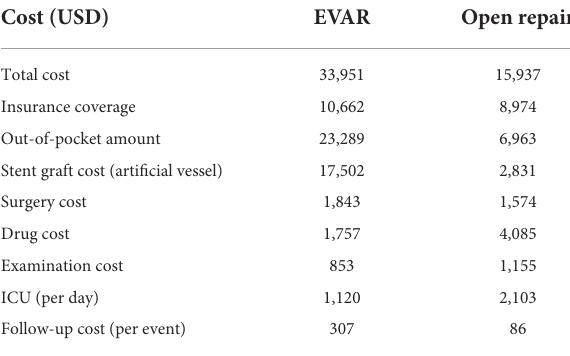
TABLE 9 The costs of EVAR and open